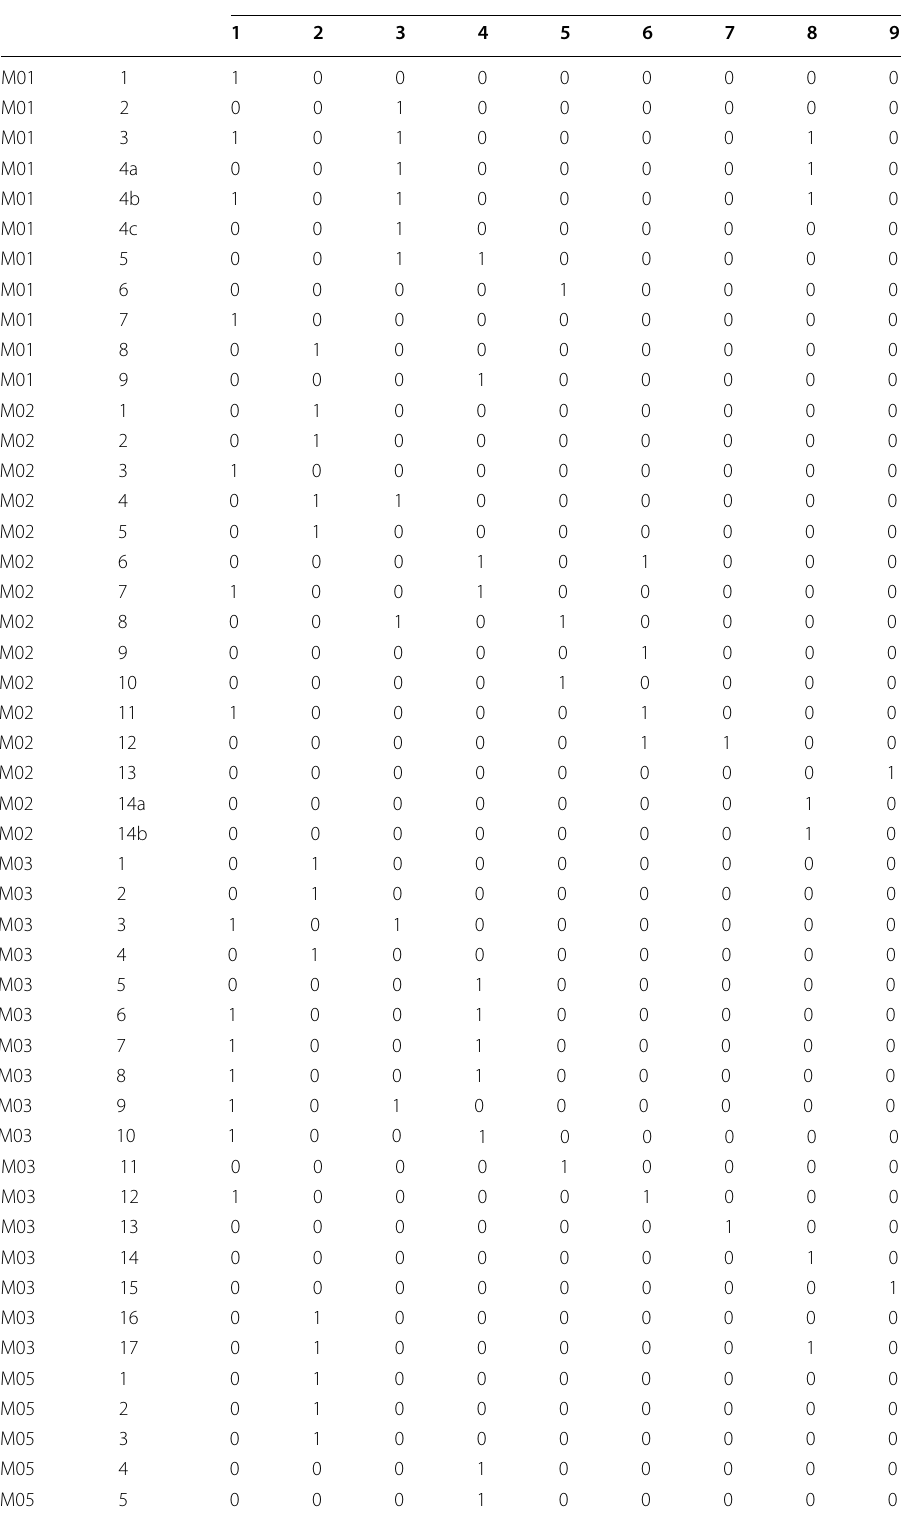
Table 11 Q-matrix Refined by the Stepwise Method: United States